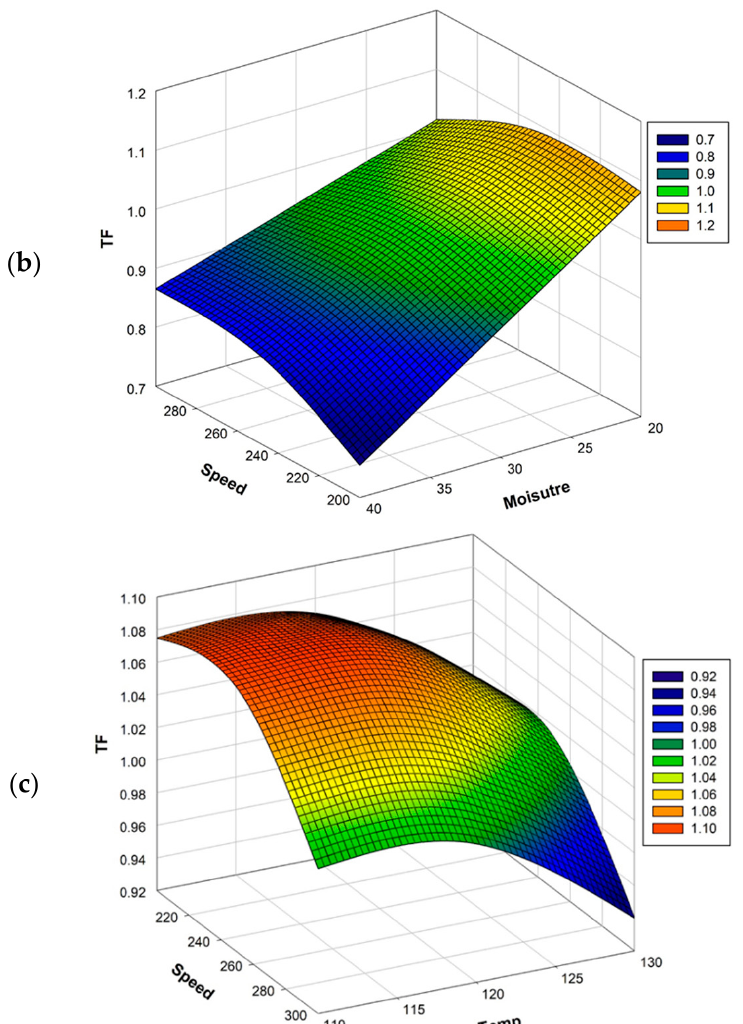
Figure 1. Response surface plots showing ( a ) the effects of temperature and moisture content, ( b ) the effects of screw speed and moisture content, and ( c ) the effects of screw speed and temperature on total flavonoid content. Temp, barrel temperature (°C); Moisture, feed moisture content (%); Speed, screw speed (rpm). TF, total flavonoid content (%).